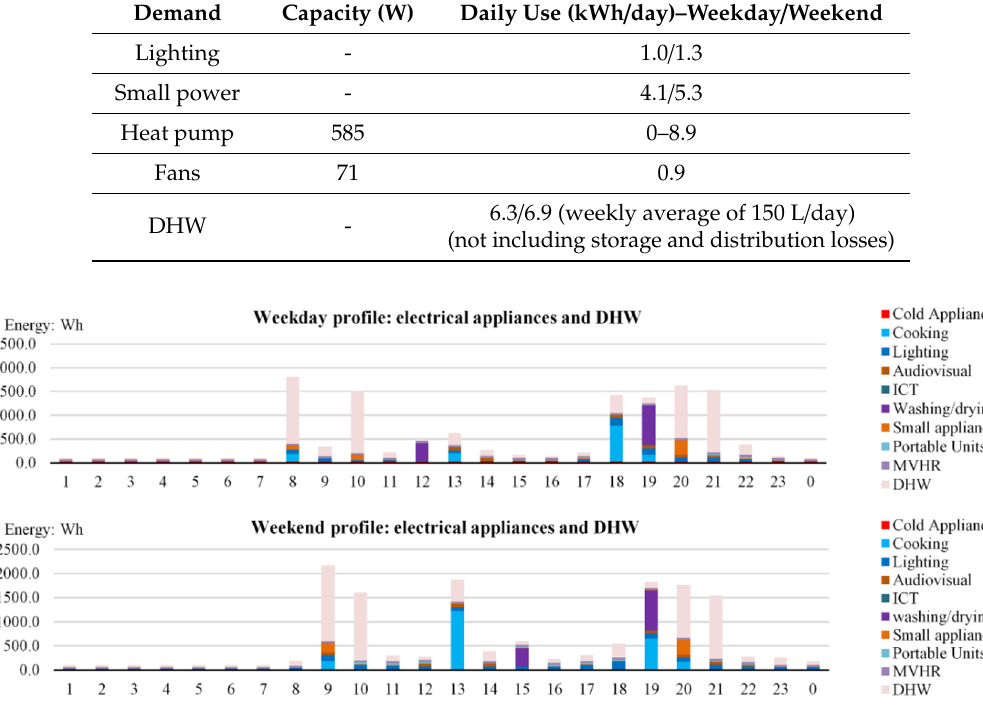
Figure 11. Weekday and weekend energy and water use profiles constructed from measured daily totals